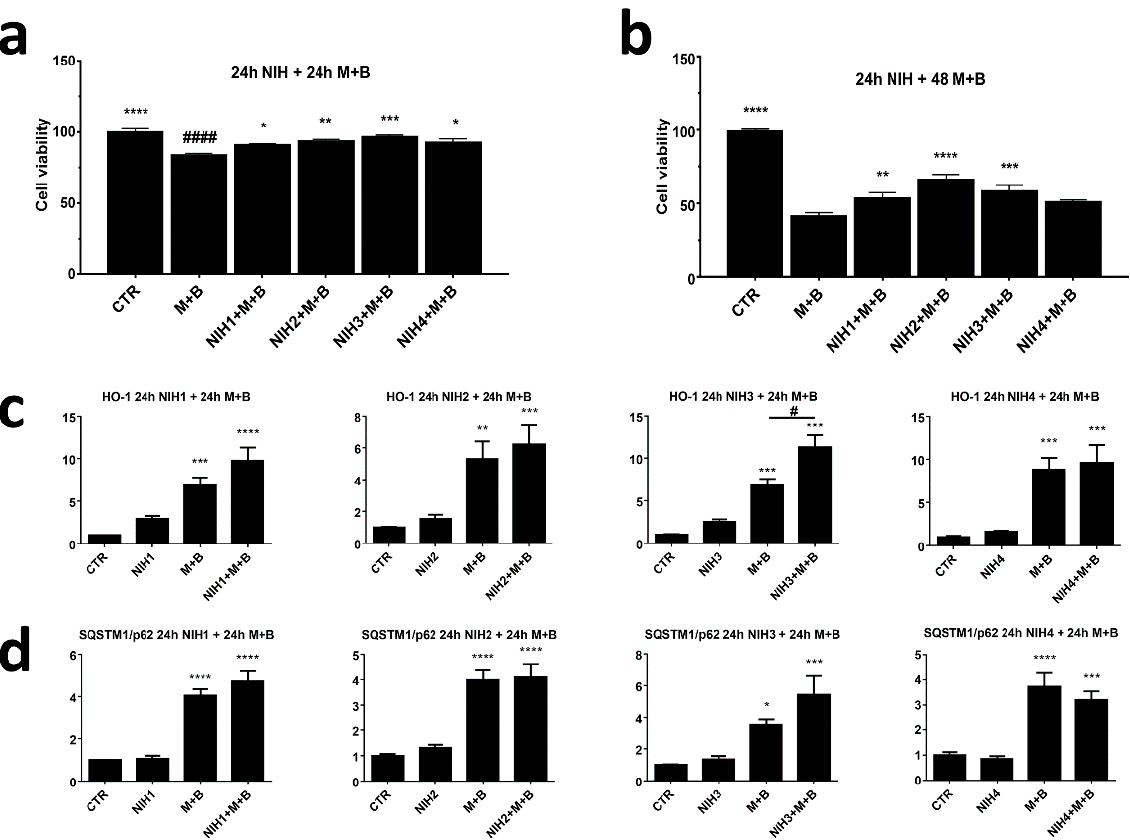
Figure 6. Cell viability and protein levels of HO-1 and SQSTM1/p62 of NIH-treated ARPE-19 cells upon inhibition of protein degradation systems. ARPE-19 cells were pretreated with NIH compounds for 24 h followed by proteasomal (M = MG-132, 5 µ M) and lysosomal acidification (B = bafilomycin A1, 50 nM) inhibition for ( a ) 24 h or ( b ) 48 h. Cell viability was measured with PrestoBlue ® , and the results are shown as percentage ± S.E.M. in comparison to control (CTR, 100%). The protein levels of ( c ) HO-1 and ( d ) SQSTM1/p62 were analyzed via Western blotting. The protein bands were quantified and normalized against α -tubulin. The results are expressed as fold change of the means compared to control (CTR) ± S.E.M. n = 6, * p < 0.05, ** p < 0.01, *** p < 0.001, **** p < 0.0001. # = statistically significant difference between MG-132 + bafilomycin A1 (M + B) and M + B + NIH1 compound (NIH1 + M+B) per Dunnett’s multiple comparisons test. #### = statistically significant difference between MG-132 + bafilomycin A1 (M + B) and CTR.